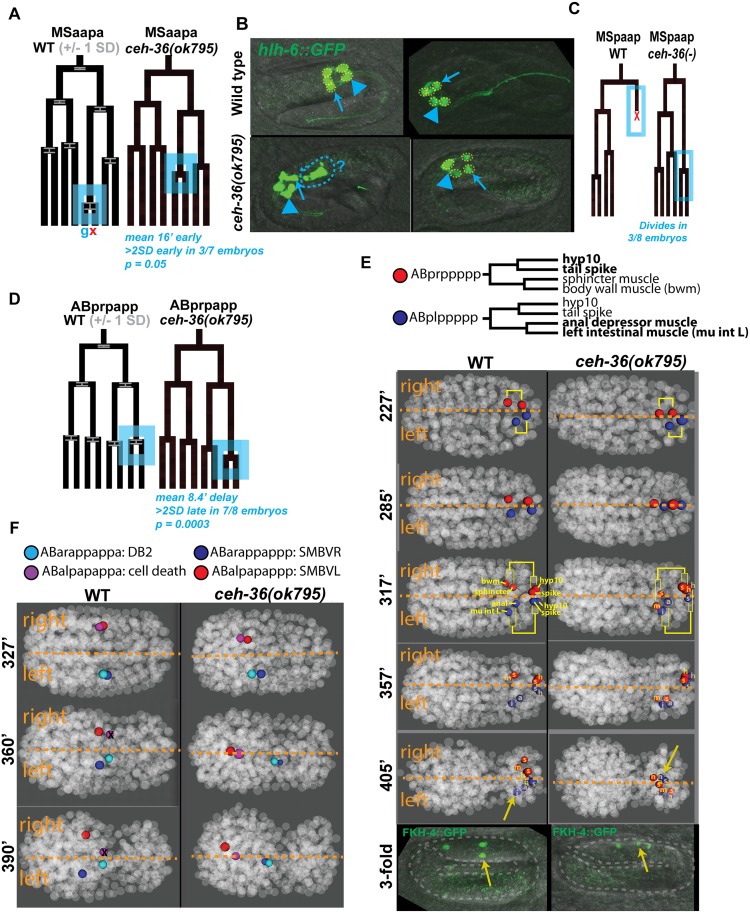
Examples of cell lineage and position defects observed in ceh-36 mutants.A) Early division of the MSaapapa cell (blue box). Cell fates under the WT tree labeled as g = pharyngeal gland, x = programmed cell death. Error bars in WT tree represent standard deviation of division time. Data for mutants are from a representative defective embryo. B) Morphological defects in pharyngeal glands (marked with hlh-6::GFP) in ceh-36(ok795); anterior gland cells (arrowhead) and posterior gland cells (arrows) show defects in organization (left panel, disorganized morphology and possible extra cells) and number (right panel, one missing posterior gland cell, yellow dashed circles) in ceh-36 mutants C) Failed cell death of MSpaapp, which instead divides. D) Late division of ABprpapppp (blue box), which produces AIMR and CEPVR neurons. E) Left-right migration defects in ABplppppp and ABprppppp lineages (cells with migration defects in bold). Sister cells denoted with yellow lineage brackets. FKH-4::GFP marks mu int L (yellow arrow), mu int R and anal depressor (S4 Fig). F) Anterior-posterior migration defects of SMBV cells and their sisters (DB2 and cell death). ABalpapappa fails to die in 7/8 ceh-36(ok795) embryos.